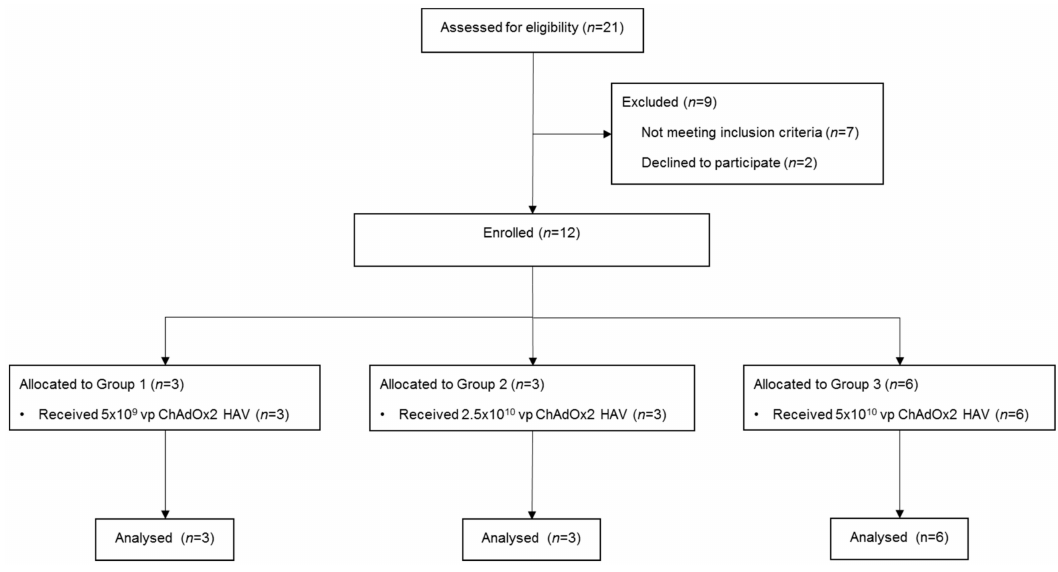
Figure 1. CONSORT diagram. Vp, viral